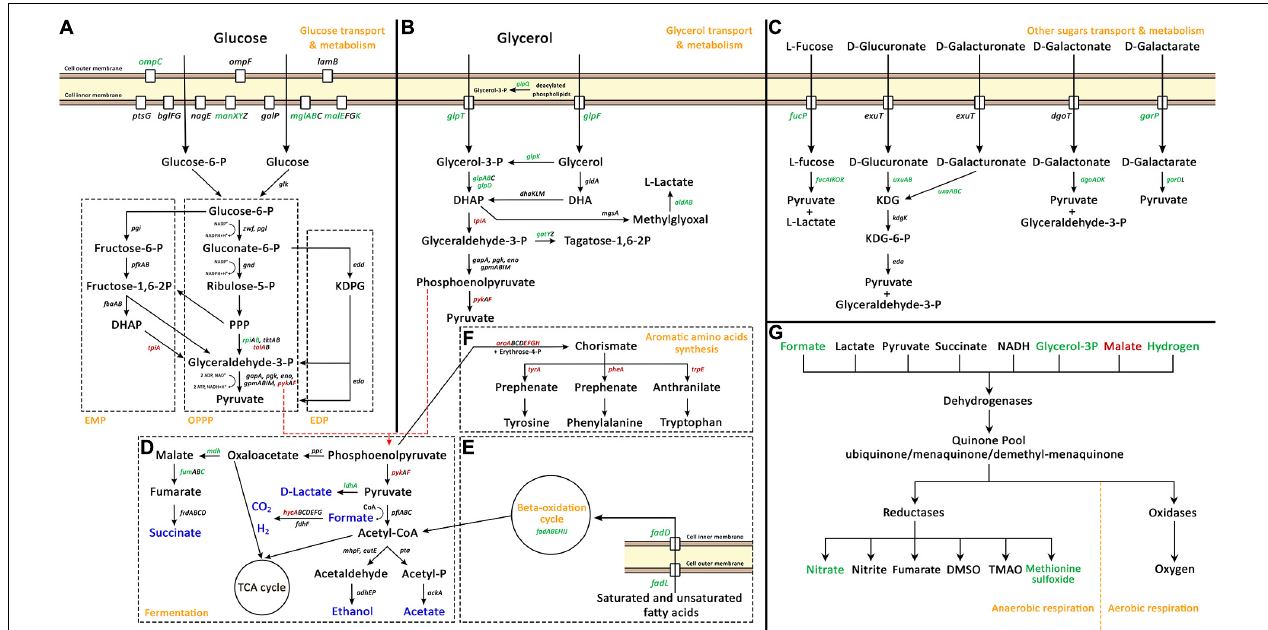
FIGURE 3 | Palladium (Pd) stress effects on genes related to carbohydrate transport, carbohydrate metabolism and energy production pathways, namely, glucose transport and metabolism (A) , glycerol transport and metabolism (B) , other sugars transport and metabolism (C) , fermentation (D) , beta-oxidation cycle (E) , aromatic amino acids synthesis (F) , and anaerobic respiration (G) . In panels (A–F) , green gene names represent up-regulated genes, red names represent down-regulated genes, and black names represent unaffected genes. In panel (D) , blue color represents fermentation end products. In panel (G) , green and red colors represent up-regulated and down-regulated parts of anaerobic respiration pathways, respectively. In panel (A) , the three native glycolytic pathways in E. coli are demonstrated: Embden-Meyerhof pathway (EMP), oxidative pentose-phosphate pathway (OPPP), and Entner-Doudoroff pathway (EDP). The full names of abbreviated compounds are DHAP, dihydroxyacetone phosphate; KDPG, 2-Keto-3-deoxy-6-phosphogluconate; DHA, dihydroxyacetone; KDG, 2-dehydro-3-deoxy-D-gluconate; TCA, tricarboxylic acid cycle; DMSO, dimethyl sulfoxide; and TMAO, Trimethylamine